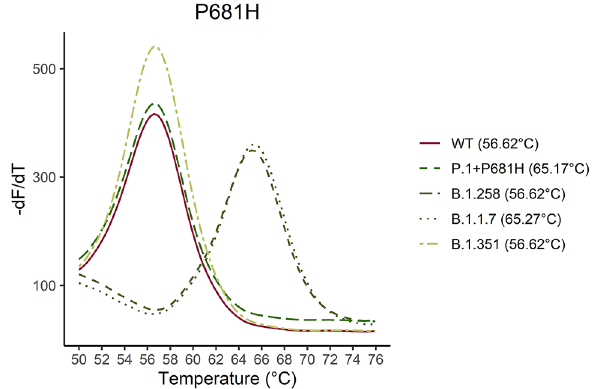
Figure 5. Five samples for the P.1 + P681H, B.1.351, B.1.1.7, B.1.258 and WT were analyzed. The melting curve of the five samples are illustrated for the P681H assay. As it is shown in the graph the P681H mutation can be distinguished by approximately 10 °C from the WT sequence.